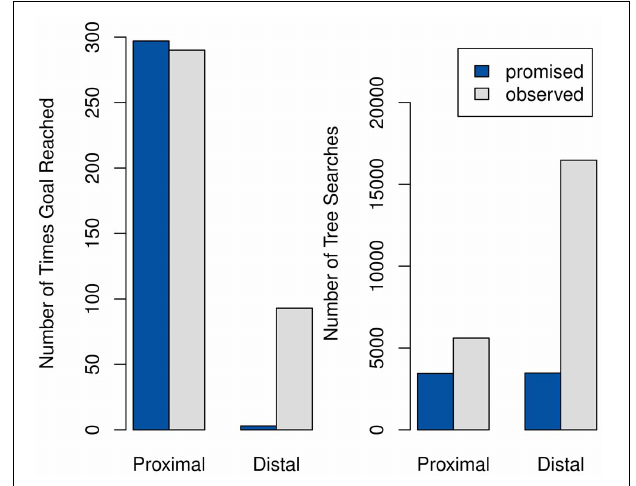
FIGURE 10 | Comparison of performance (left) and speed (right) between systems with promised extrinsic rewards (dark gray) and with only observed rewards (light gray). As one tree-search takes an average of 350ms, compared to less than a millisecond needed for querying the habitual system, the number of tree-searches is directly proportional to the total